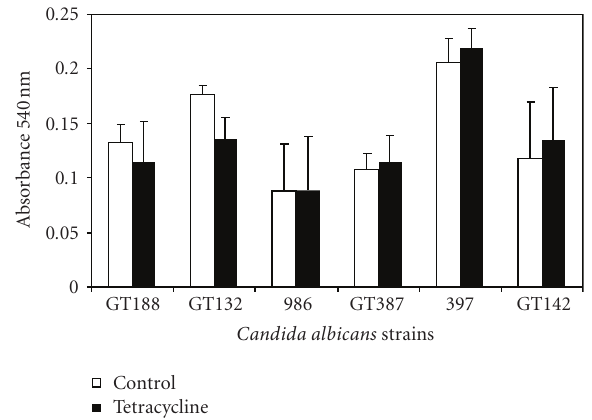
Figure 5: Very little hemolytic activity was detected in cultures of Candida albicans regardless of the presence or absence of added tetracycline (0.1 μ g/mL). The greatest amount f hemolysis detected was 4% lysis of a 1% erythrocyte suspension. As shown by the figure, there was minimal di ff erence between strains employed in this evaluation. It may be concluded that tetracycline has a negligible e ff ect on hemolytic activity of Candida